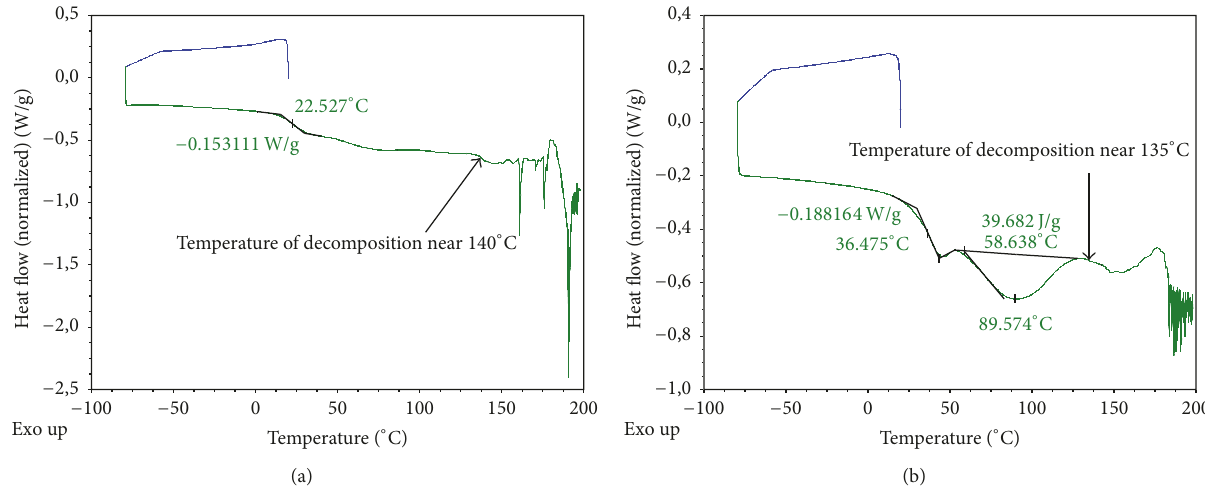
Figure 5: DSC curves corresponding to OsLu (a) and Vivinal GOS (b), using a heating rate of 10 ∘ C/min and one cycle of heating and cooling.